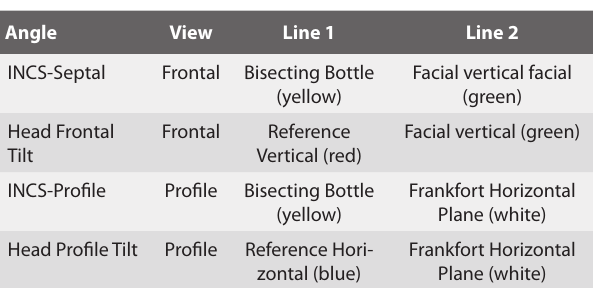
Table 1. Definition of angles .